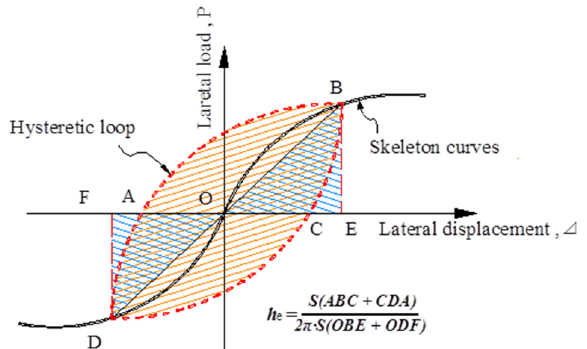
Figure 13. The energy dissipation capacity. Figure 12. An energy dissipation capacity calculation diagram. Appl. Sci. 2020 , 10 , x FOR PEER REVIEW Figure 12. An energy dissipation capacity calculation diagram.